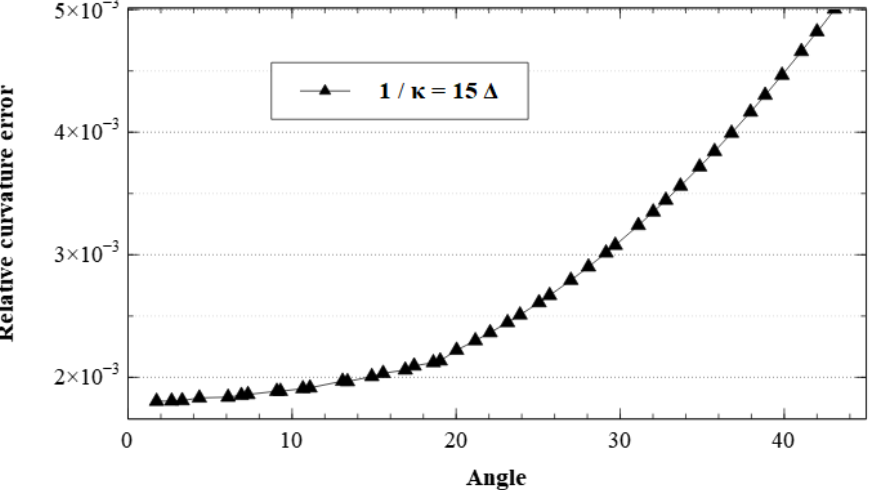
Figure 5. Relative curvature errors with the height function methodology along the circular interface as a function of the interface inclination angle with respect to the